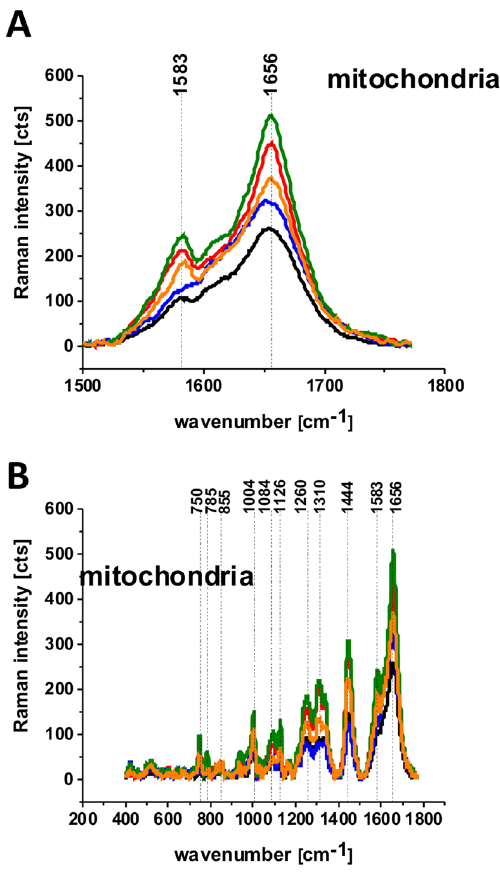
Figure 10. The average Raman spectra of human lung single cell CCL-185 without glucose supplementation (black line), supplemented with glucose (green line) and deuterated glucose (red line) at normal conditions (5 mM) and supplemented with glucose (orange line) and deuterated glucose (blue line) at hyperglycemia conditions (100 mM) for 1500–1800 cm −1 spectral region ( A ) and for 200–1900 cm −1 spectral region ( B ) obtained from Raman images of separate clusters identified by Cluster Analysis method assigned to: